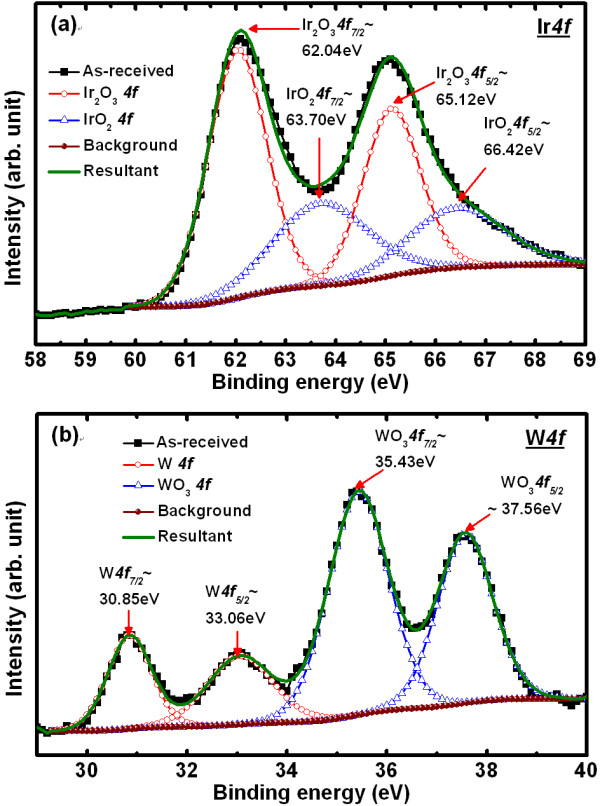
XPS of Ir4f electrons from the IrOx-NDs and W4f core-level electrons in the WOx layer. (a) XPS of the Ir4f electrons from the IrOx-NDs and (b) W4f core-level electrons in the WOx layer.